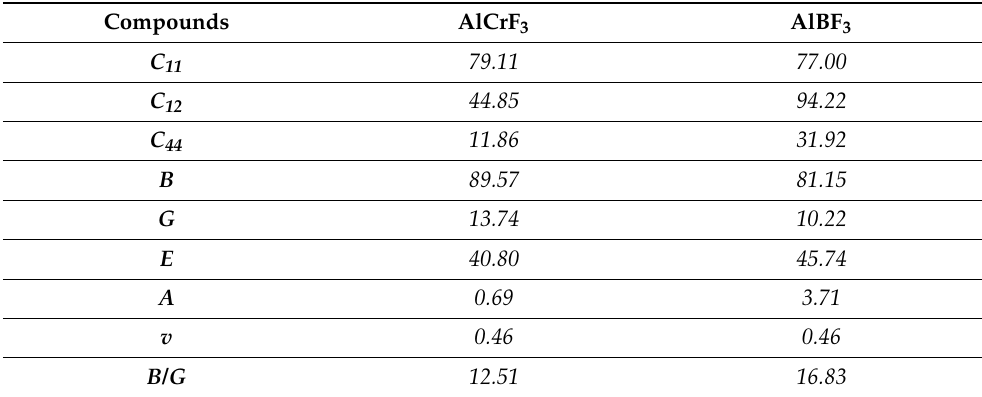
Table 2. Simulated mechanical parameters of AlMF 3 (M = Cr, B) using the IRelast package.